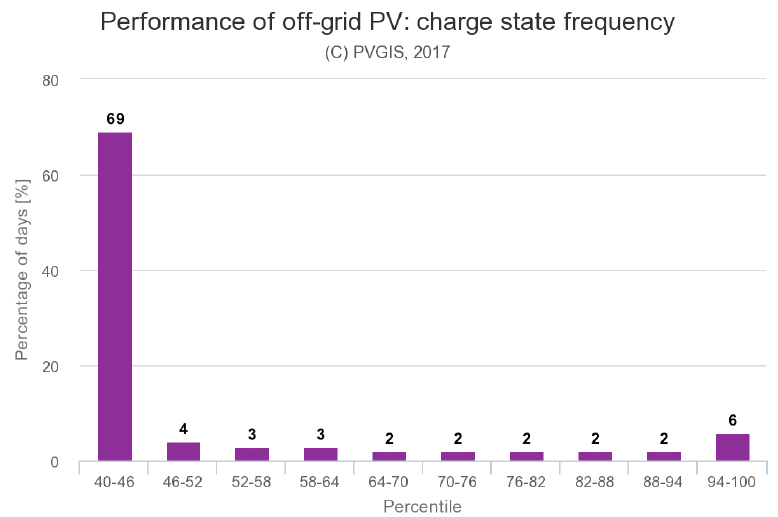
Figure A1. Charge state of the storage battery.